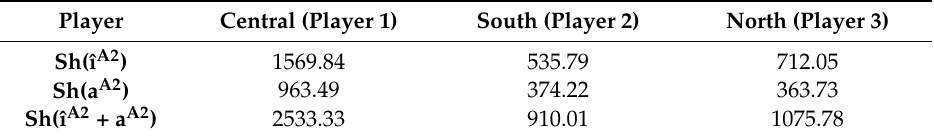
Table 26. Shapley Values for games î A2 (S) and a A2 (S).